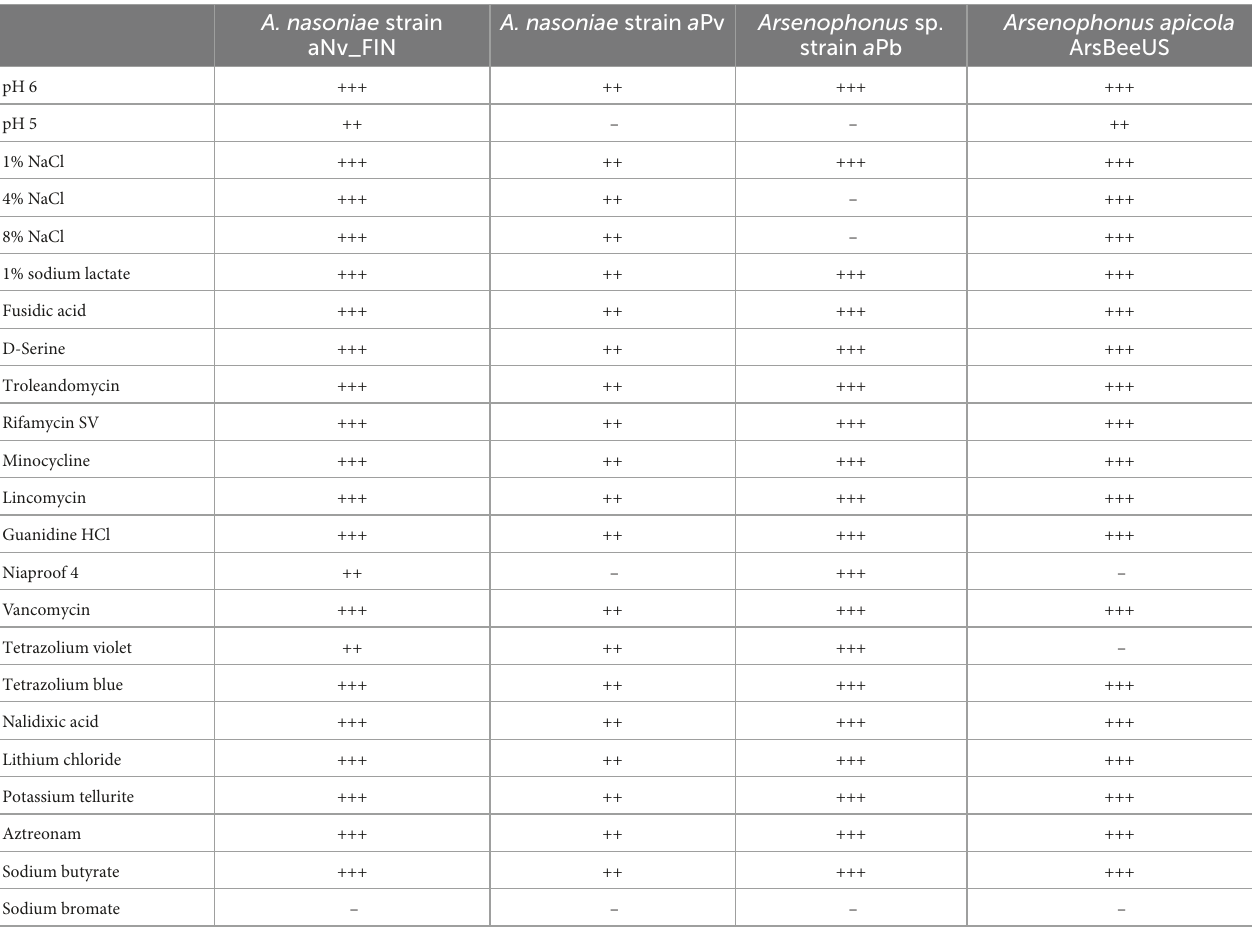
TABLE 2 Impact of environmental and xenobiotic stress conditions on growth of Arsenophonus strains on Biolog III